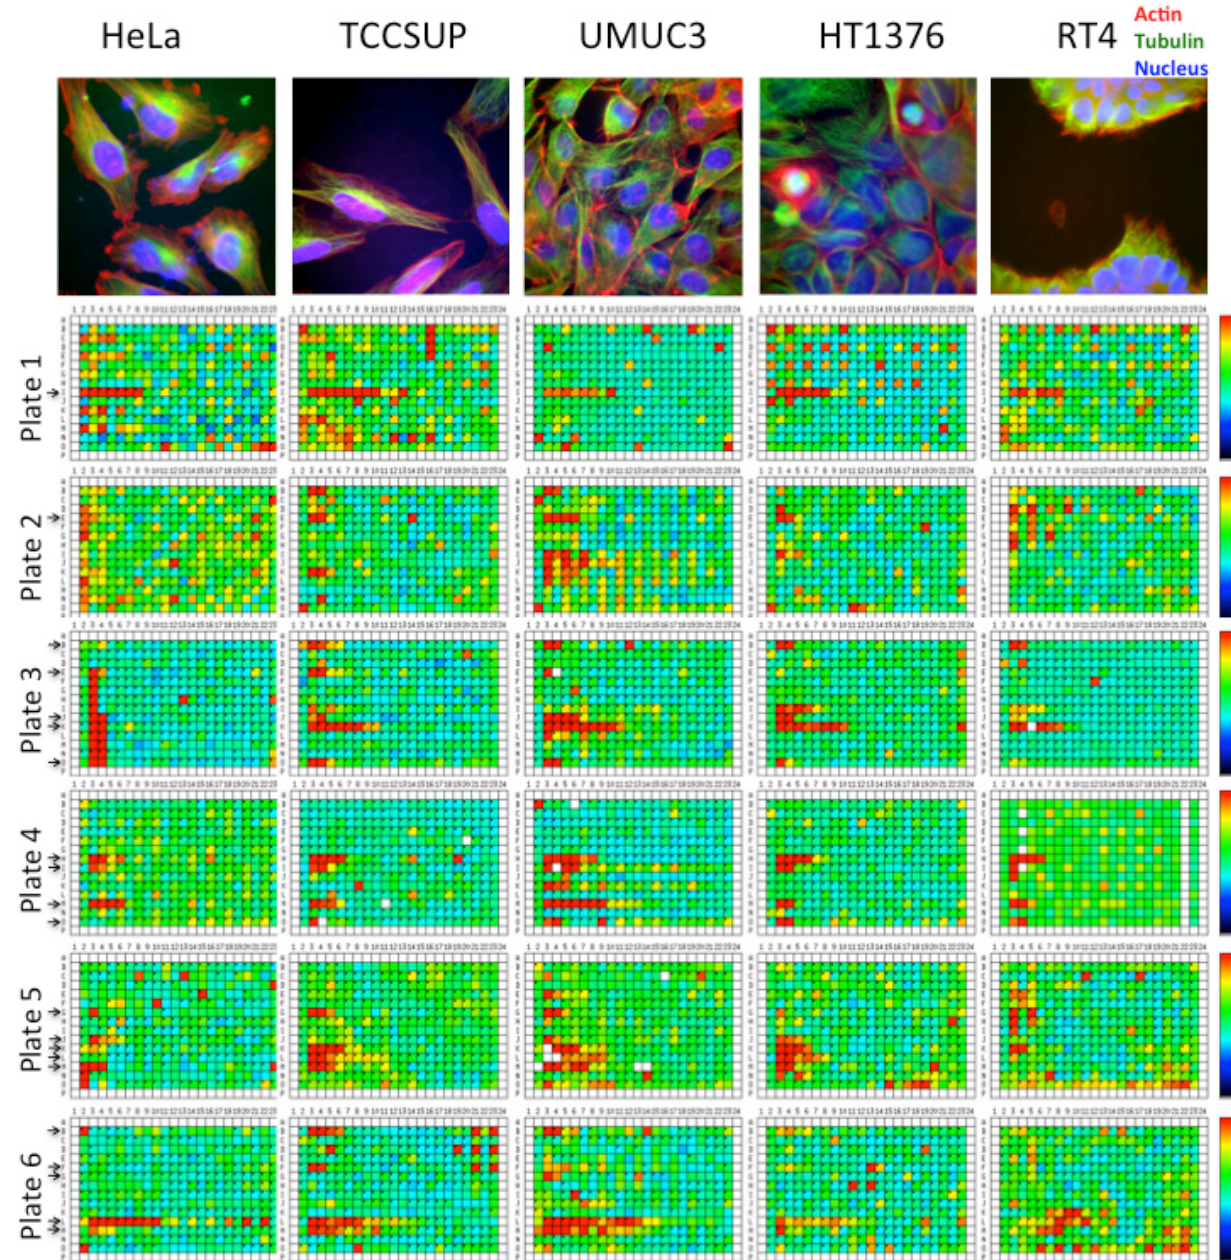
Figure 1. Cell imaging and multi-parameter analysis. Five cell lines were cultured each in six 384 plates treaded with concentration- dilution series of the COMBO drug plate (see Table 1 for drug order, each plate row is a dilution series in duplicates). Cells were imaged in three fluorescent colors (Red: Acin, Green:Tubulin & Blue:Nucleus, See image examples in top pannels). Individual cells were segmented, and for each cell an array of attributes was quantified. Attributes include cells and nuclei morphological and fluorescence intensities attributes and microtubules and actin fiber attributes (see Methods and Extended data: Table S2). Color coded Mahalanobis Scores (see Extended data: Figure S2) are presented here for each well in six plates for the five cell lines. A number of drugs with strong cellular effects are displayed (red rows), and indicate some cell-line dependence. Robot error effects were minimized in the analysis by rejecting outliers lying outside the robust PCA